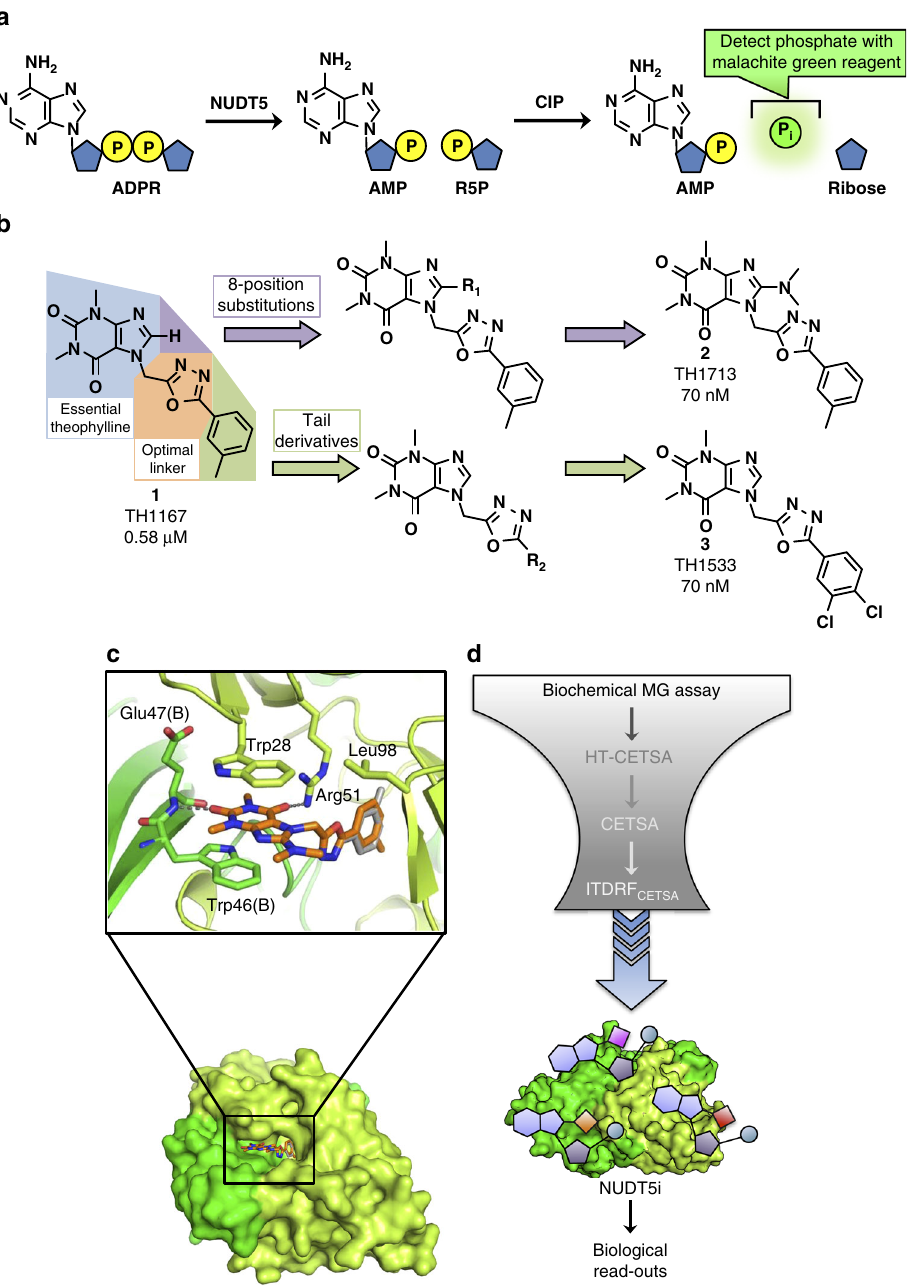
Fig. 2 Development of potent NUDT5 inhibitors from a high-throughput screening campaign. a A representation of the enzyme-coupled malachite green assay (MG assay). ADPR is hydrolyzed to AMP and R5P by NUDT5, then R5P is converted to free inorganic phosphate detected by the malachite green reagent. b Preliminary structure – activity relationship study for determining where modi fi cations are tolerated. Favorable optimization of TH1167 was performed by modi fi cation at the theophylline 8-position (purple) and tail position (green) of the molecule. MG assay IC 50 values are reported below the chemical structures. c Structure of NUDT5 with inhibitor TH1713. Binding of TH1713 (orange) by NUDT5 dimer (chain A, limon green and chain B, green) through stacking between Trp28 of chain A and Trp46 of chain B and hydrogen bonds to the amide nitrogen of Glu47 and side chain of Arg51. An alternate conformation of the methylbenzene modality is modeled in gray. d NUDT5 inhibitor screening funnel optimized to select for target engagement in